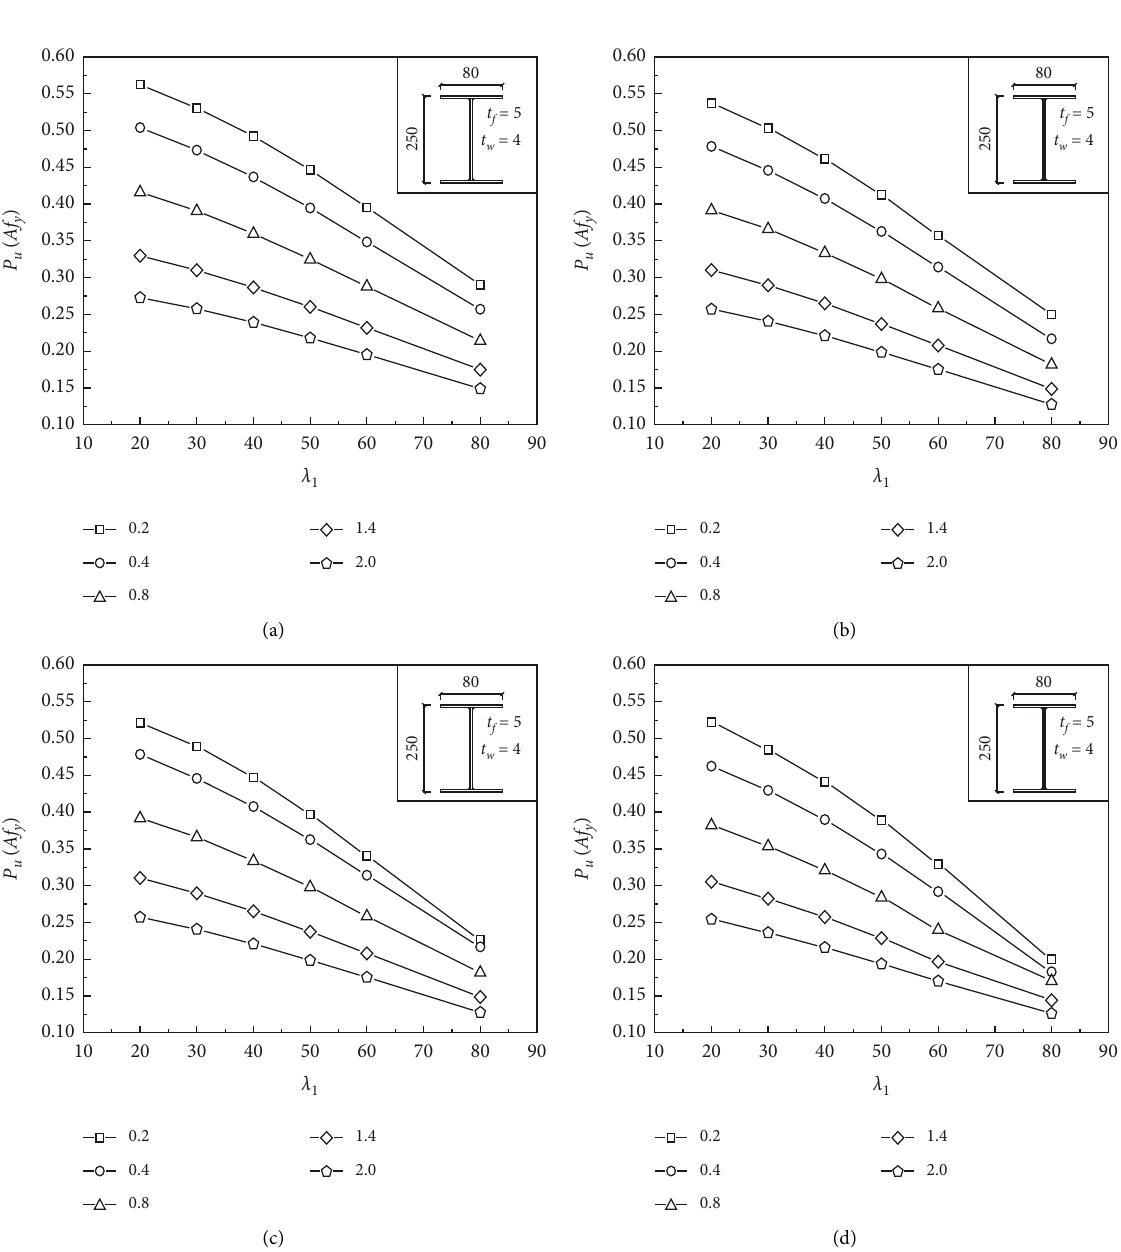
u / Af y ) versus overall slenderness λ l under different &epsi; curves: (a) Q460; (b)